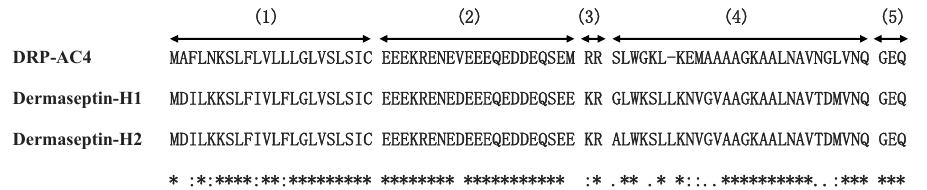
Figure 2. The alignment of full-length amino acid sequences and domain architecture of precursors encoding DRP-AC4, Dermaseptin-H1 and Dermaseptin-H2. (1) Signal peptide; (2) Acidic spacer peptide region; (3) Dibasic propeptide convertase processing site; (4) Mature peptide; (5) Glycine residue amide donor. Conserved amino acids are indicated by asterisks.